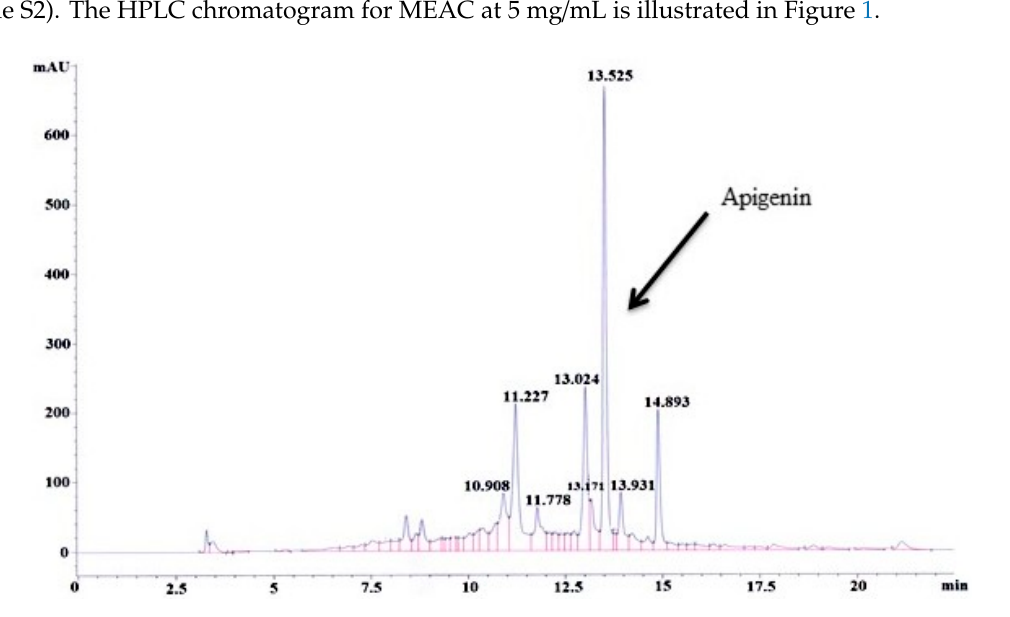
Figure 1. HPLC chromatogram for methanolic extract of Averrhoa carambola leaf (MEACL) at 5 mg/mL.